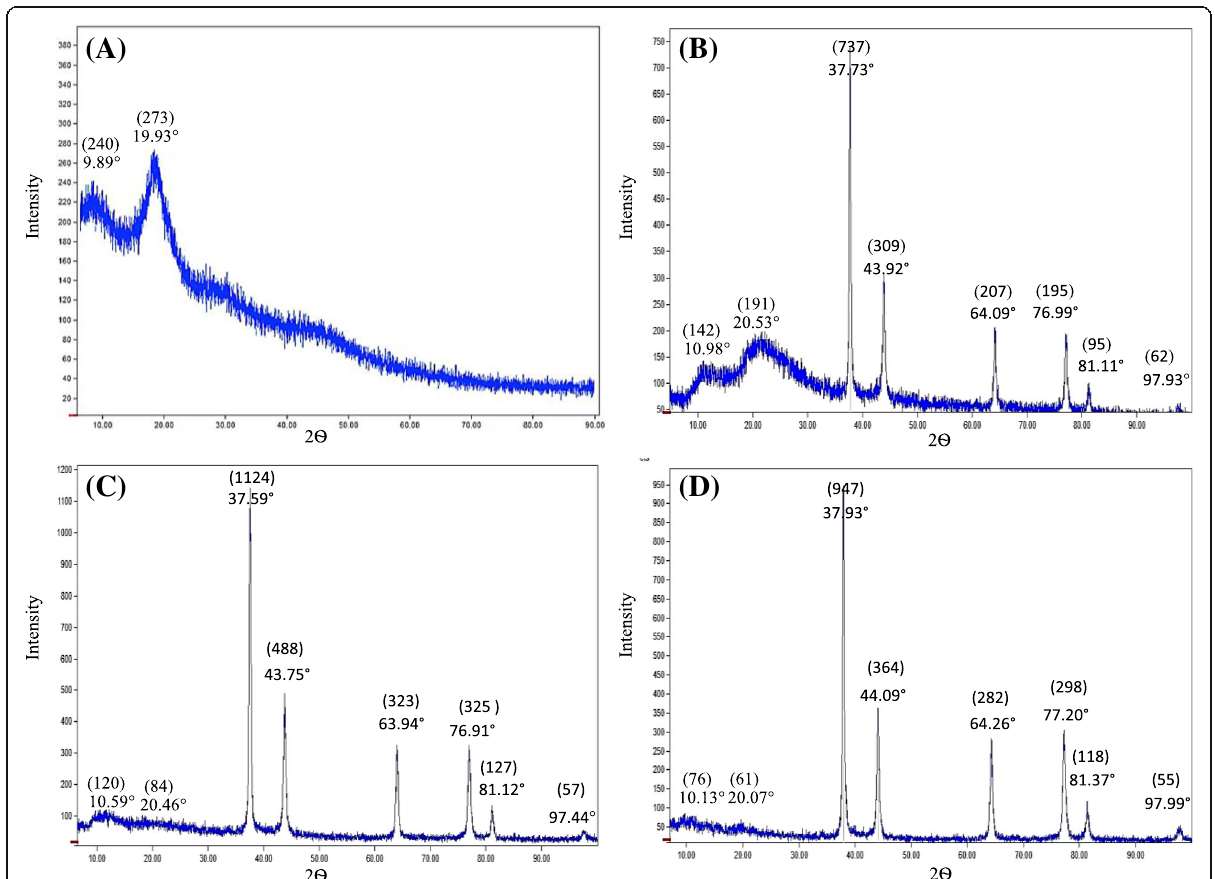
Fig. 3 X-ray diffraction (XRD) patterns of chitosan ( a ) and Ch-AgNPs ( b – d )